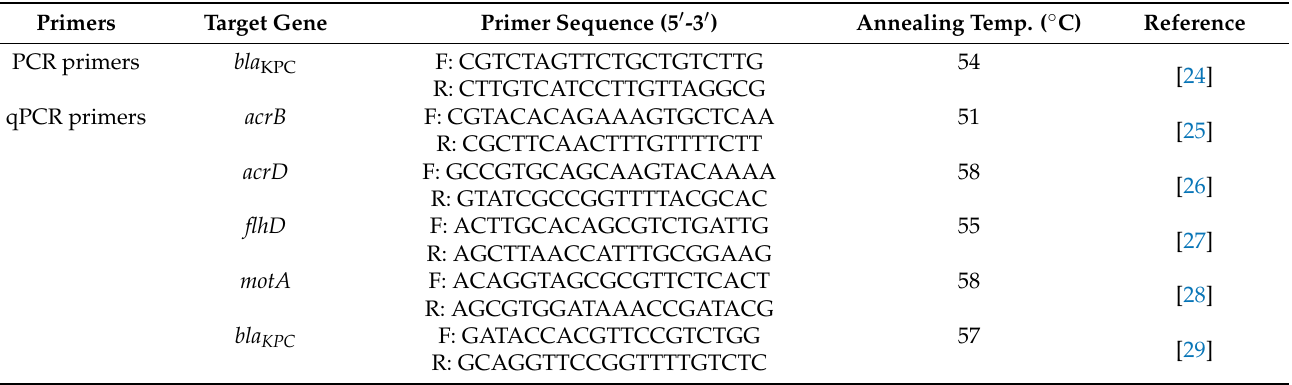
Table 3. PCR primers used in this